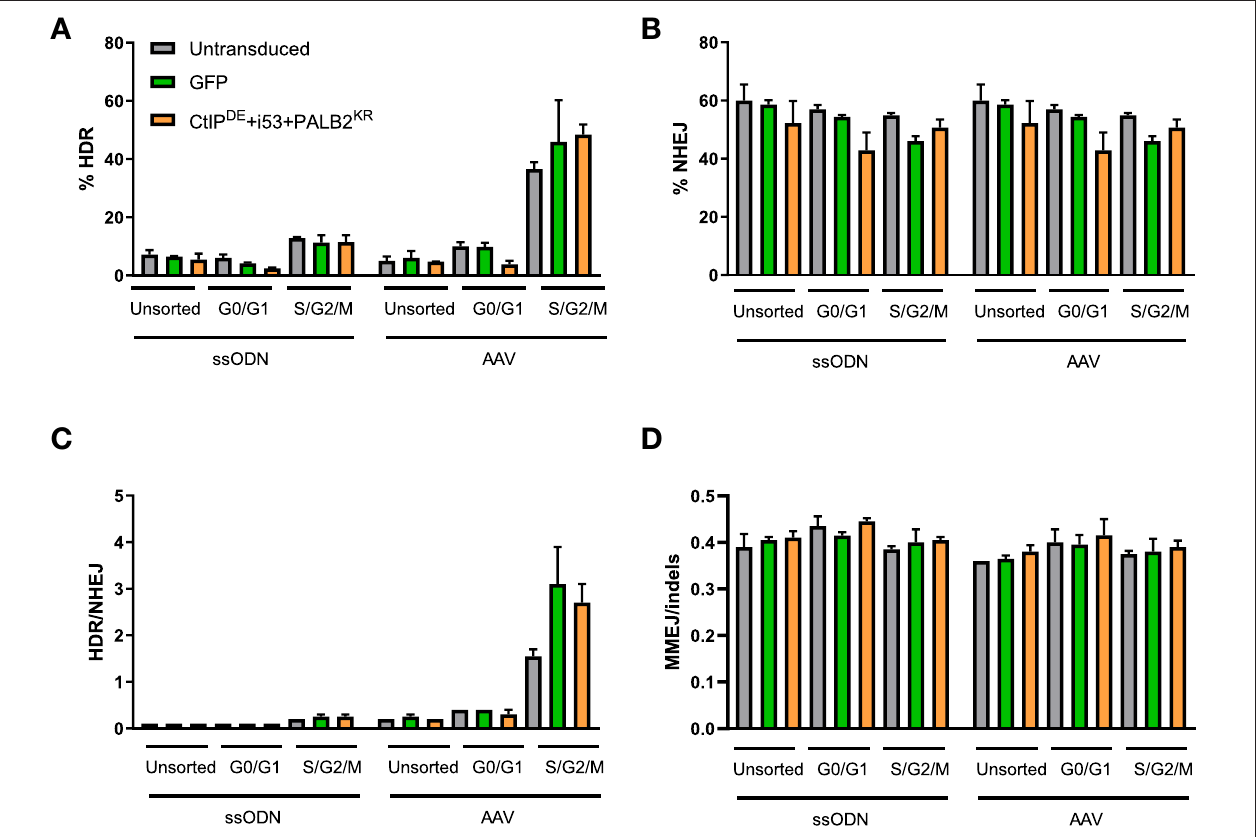
FIGURE 3 | CtIP DE + PALB2 KR + i53 overexpression in G1 phase of the cell cycle does not activate HDR. (A–D) Gene editing levels in sorted populations. Hoescht stain was used to discriminate G0/G1 and S/G2/M phases. Cells were pre-transduced with the indicated DNA RFs or GFP LVs, sorted into cell cycle phases and then electroporated with Cas9 RNP and ssODN or transduced with an AAV6 donor template immediately after electroporation. HDR and NHEJ levels were measured by HTS. (A) HDR, (B) NHEJ, (C) HDR/NHEJ, (D) MMEJ/indels, in unsorted, G0/G1-sorted, or S/G2/M-sorted populations. n = 2 biological replicates. Error bars, mean ±